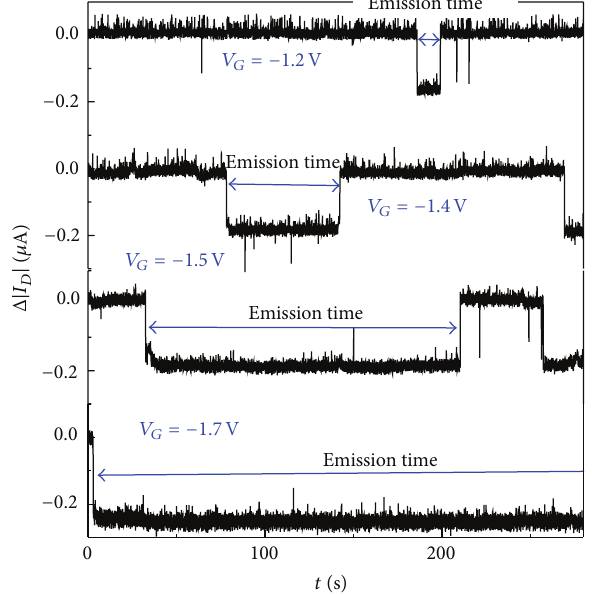
Figure 6: The transformation of transience signal from 𝐼 𝐷 -Step to 𝐼 𝐷 -RTN could be seen by decreasing the gate bias from − 1.5 V. And the emission time of this trap is obviously decreased from larger than 300 s to about 10s when gate bias is decreased from − 1.7 V to − 1.2